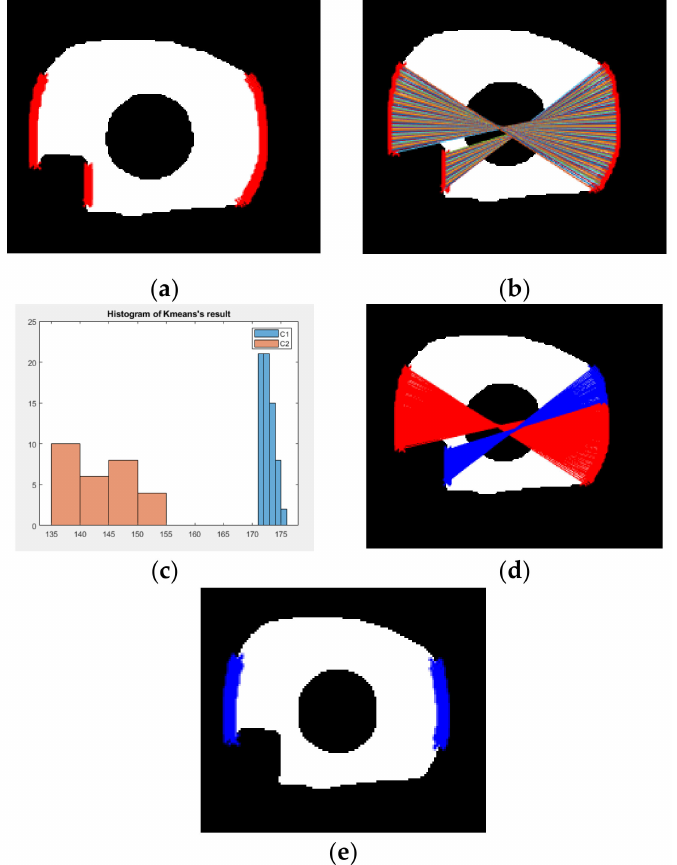
Figure 5. The illustration of the algorithm “Scan-and-Cluster” to find the saliency points of outer boundary. ( a ) Red dots denote all boundary points on the left and right side of region of interest (ROI) (within the range between 0.25 × and 0.75 × height of iris mask region); ( b ) paired iris points used to compute the distance; ( c ) histogram distribution of the length of lines; ( d ) the paired points of two cluster (red lines denote cluster one and blue lines denote cluster two); ( e ) blue dots denote all recovered saliency points after applying